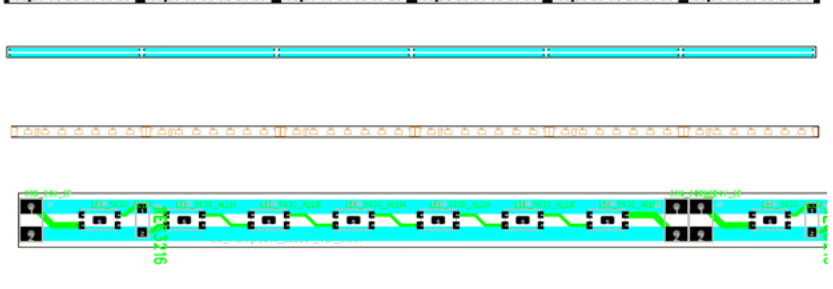
Figure 8. Circuit diagram of overall LED module design.